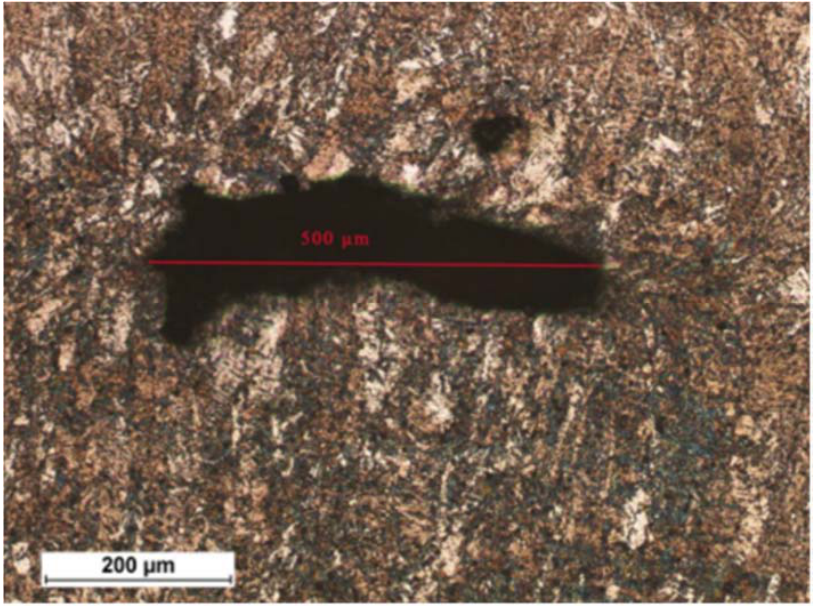
Figure 11. Size of the gas pore in joint No. 3.